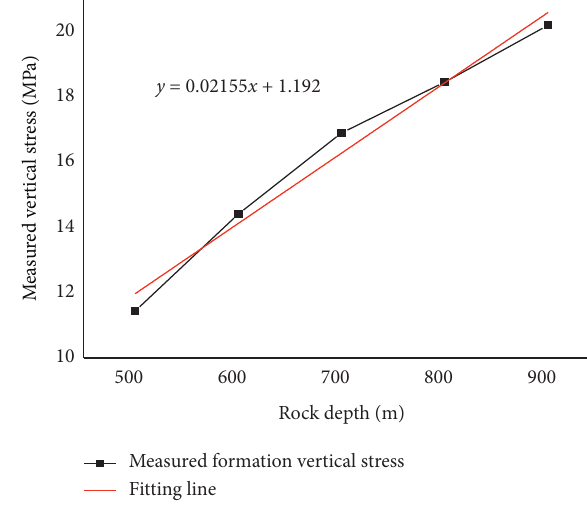
Figure 6: Numerical simulations of the contact forces at different depths.